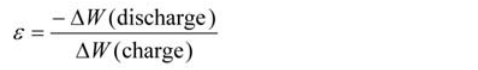
(from C/10 up to 30C in the potential window 2.7–4.1 V vs. Li) and c) LiCoO 4